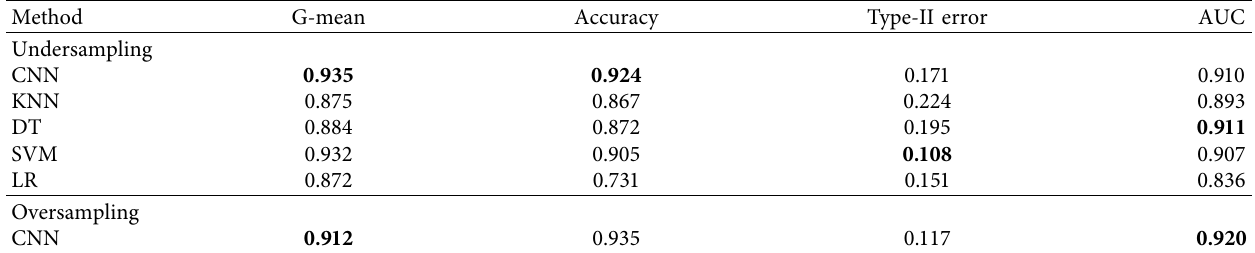
Table 12: The comparison experiments of undersampling and oversampling on China